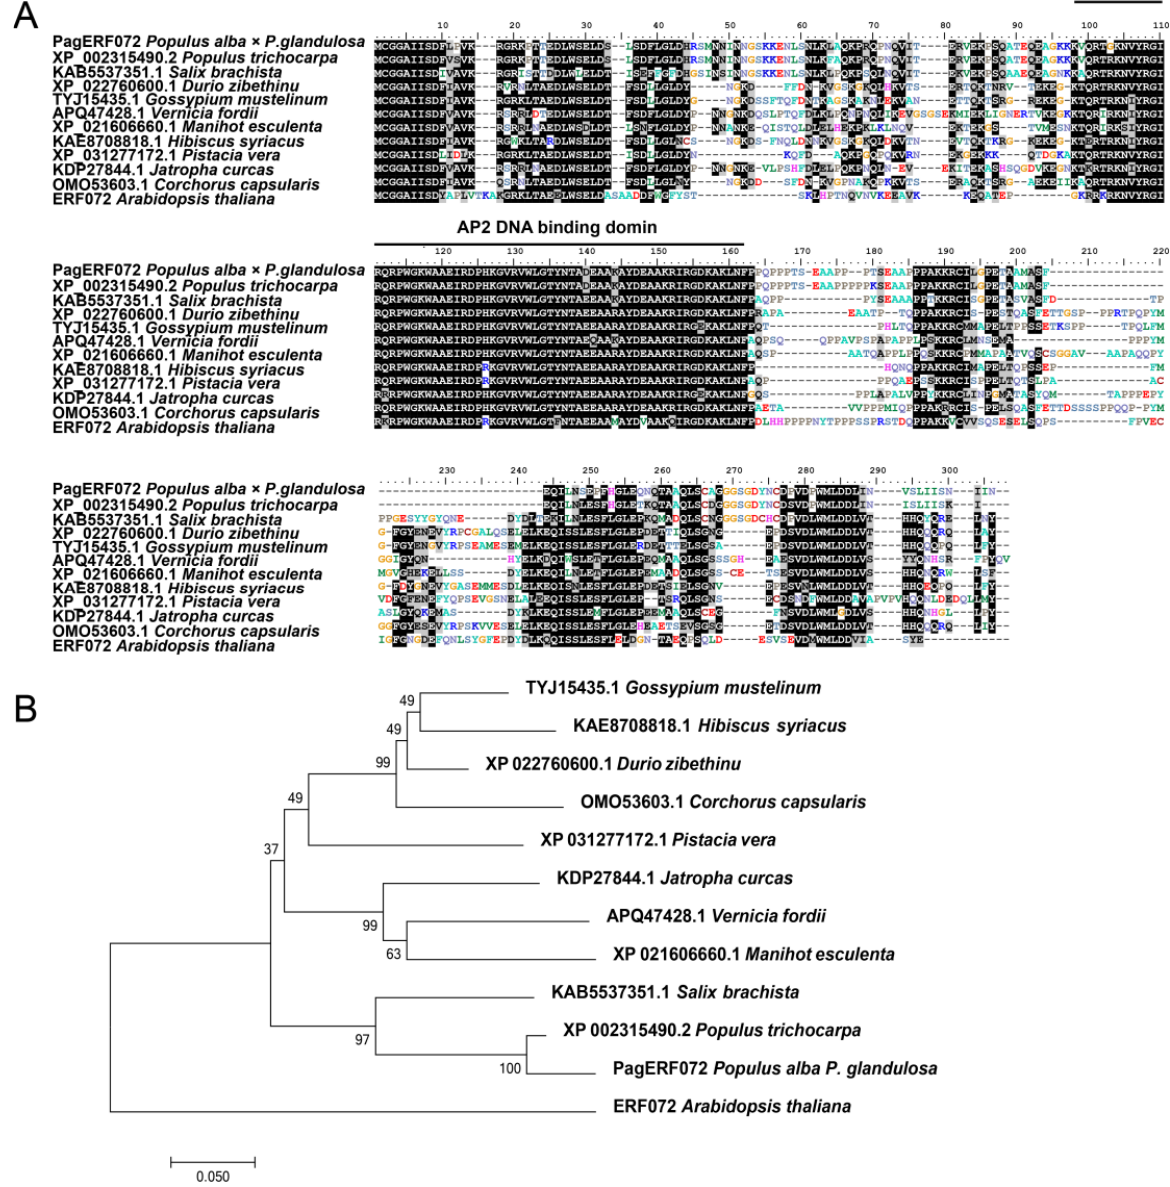
Figure 2. Sequence analysis of PagERF072 protein. ( A ) Protein alignment of PagERF072 and its homologous proteins from other plant species. ( B ) Phylogenetic analysis between PagERF072 and other ERF proteins. Multiple alignments of protein sequences were compared by ClustalW. The phylogenetic tree of homologous proteins was constructed by MEGA6 using the neighbor-joining method with a bootstrap value of 1000